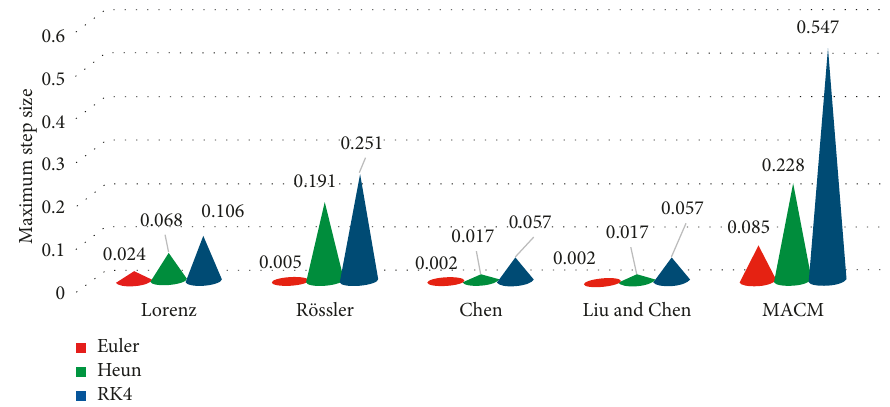
Figure 1: τ max summary of chaotic degradation of the five 3D CSs in their